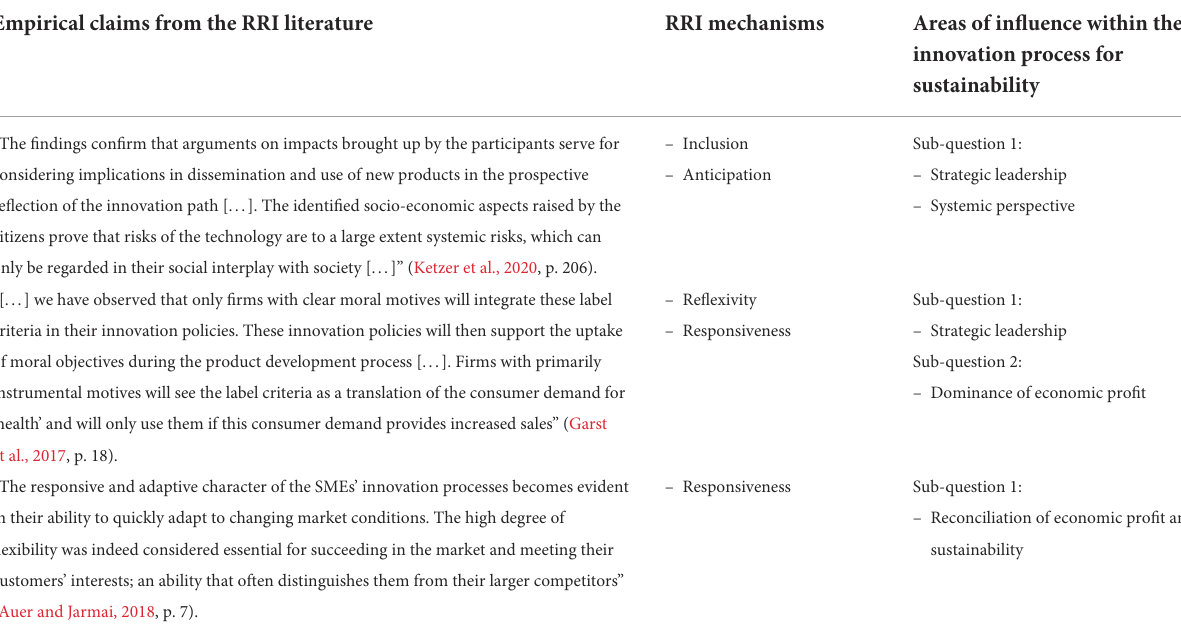
TABLE 2 Illustrative alignment of framework through inductive coding.